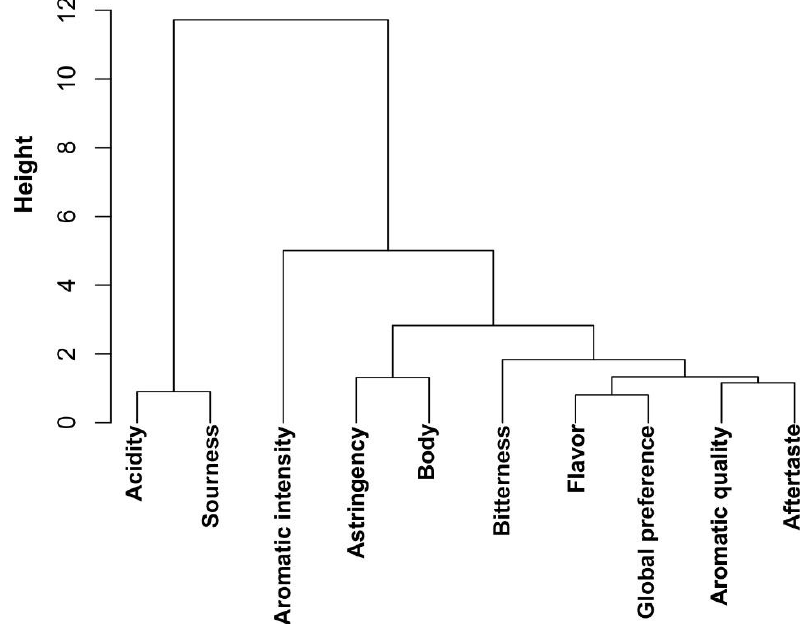
Figure 4. Cluster dendrogram of correlation between cup quality attributes of coffee beverage. Hierarchical clustering was calculated with the ward.D2 method; correlation distances were calculated by employing the scores of every sensory trait determined by the trained cup-tester panel.